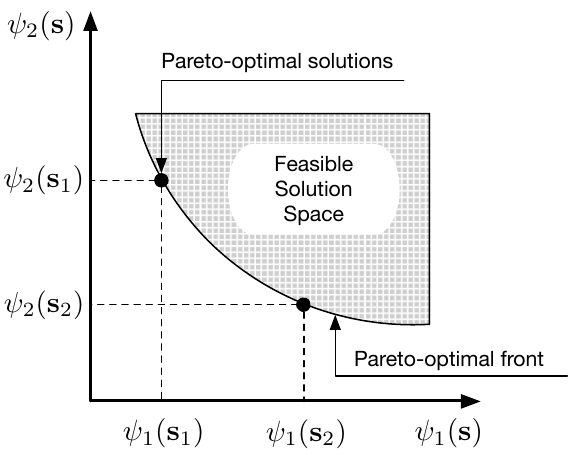
Figure 3. Multi-objective optimization aims to find pareto-optimal solutions in a feasible solution